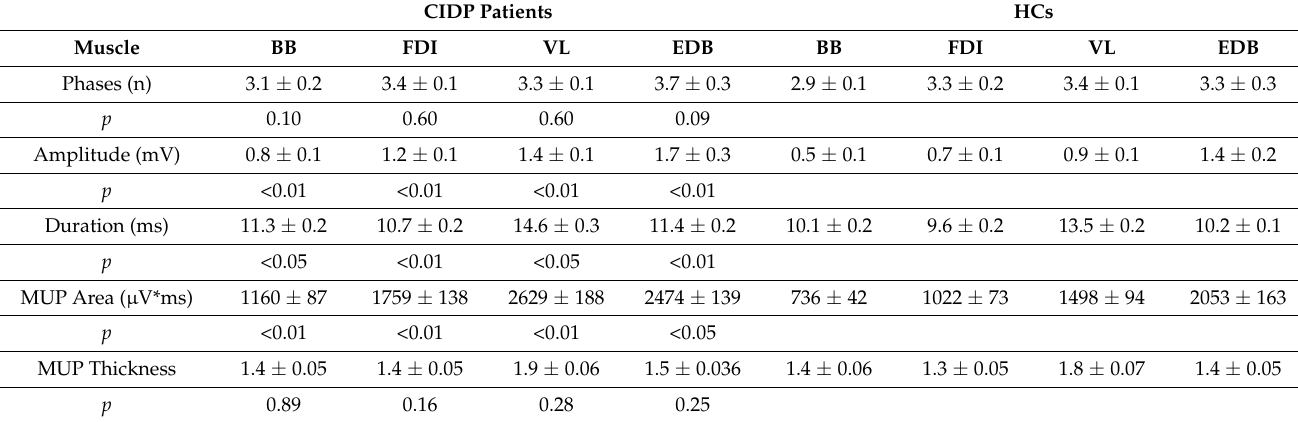
Table 4. “Conventional” and “non-conventional” MUP parameters in CIDP patients after ScIg treatment and